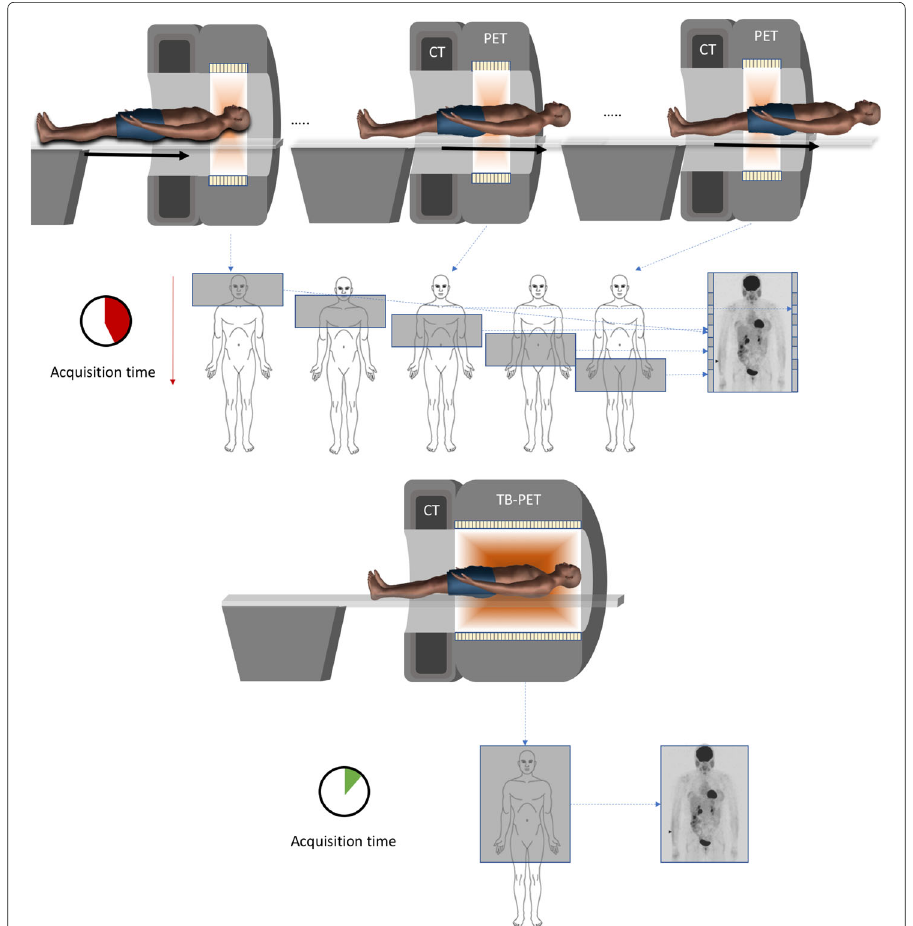
Fig. 2 The difference between a current PET-CT (top figure) and a total body PET-CT (bottom figure). Different bed positions to complete a body scan are not required anymore. Inside the total body PET FOV, higher sensitivity is obtained for each point in the FOV by the larger solid angle coverage (indicated by the shading). For the same activity injected in the patient, the total acquisition time can be reduced by a large factor due to the higher